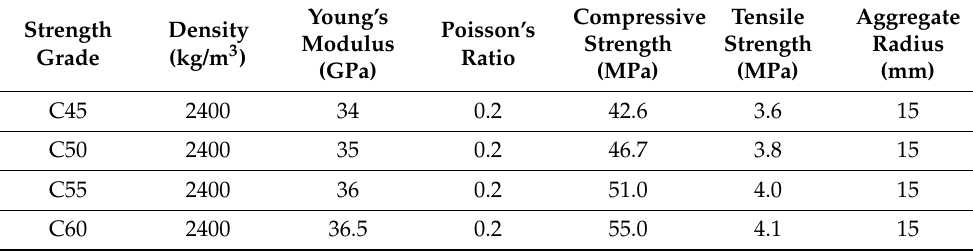
Table 2. Material properties of concrete.